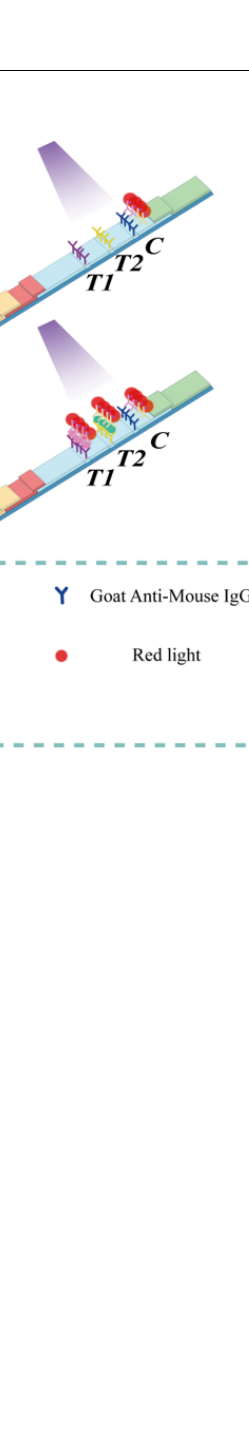
Molecules 2023 , 28 , 2104